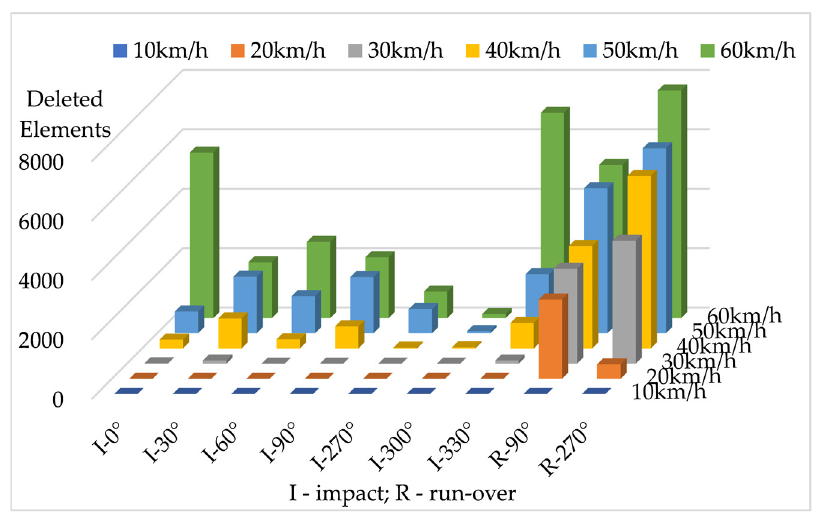
Figure 9. Relationship between the loading conditions and severity of pelvic fracture (deleted element numbers).